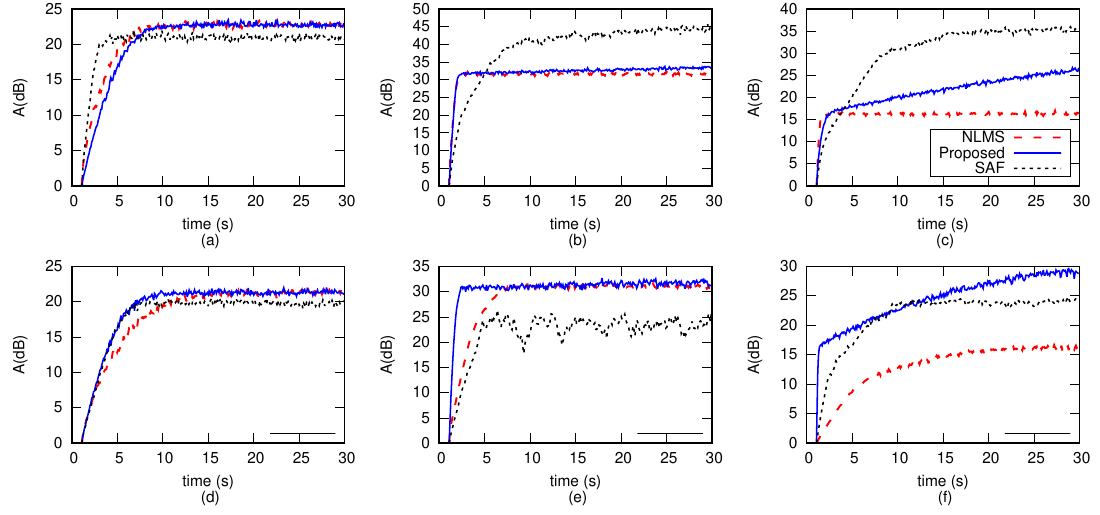
Figure 8. Test case 2: ( a ) x ( n ) is white noise and plant noise ratio is 60 dB; ( b ) x ( n ) is multi-tonal noise and plant noise ratio is 60 dB; ( c ) x ( n ) is mono-tonal noise and plant noise ratio is 60 dB; ( d ) x ( n ) is white noise and plant noise ratio is 10 dB; ( e ) x ( n ) is multi-tonal noise and plant noise ratio is 10 dB; ( f ) x ( n ) is mono-tonal noise and plant noise ratio is 10 dB; The control filter length is L = 1024. Legend is the same for all subfigures